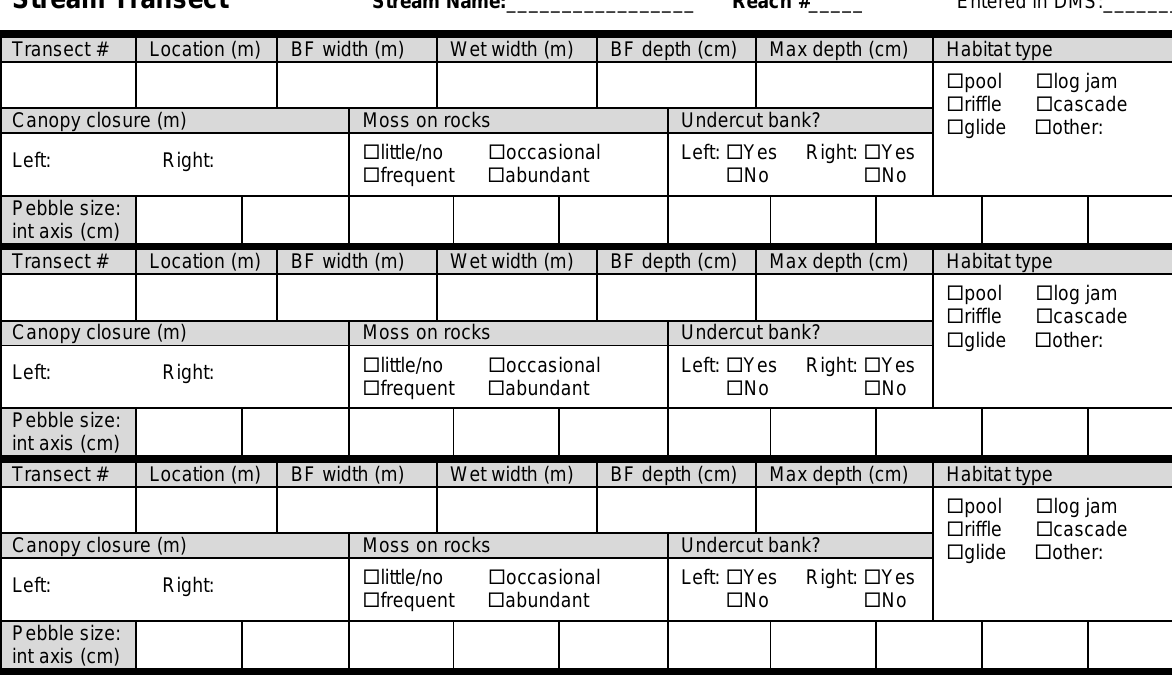
Fig. A1.1 – The Stream transect card used to record stream characteristics at multiple cross- sectional transects within a